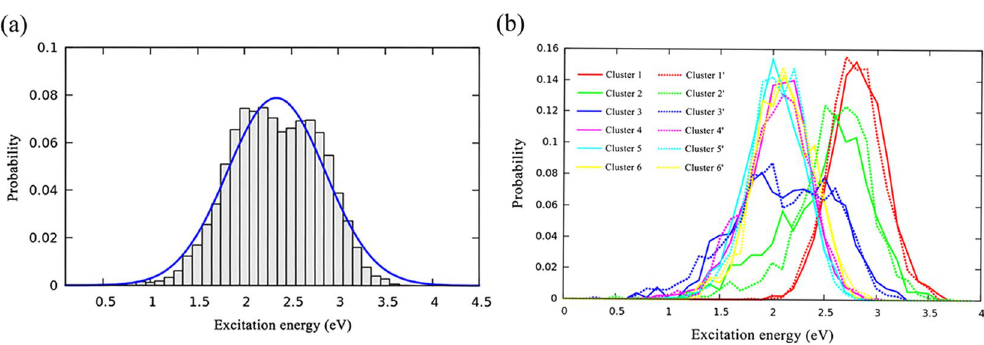
Figure 3. ( a ) The distribution of excited energies for all meta-stable patterns. The fitted Gaussian distribution curve is shown ( μ = 2.34, σ = 0.52). ( b ) The Gaussian distribution of excited energies for each meta-stable